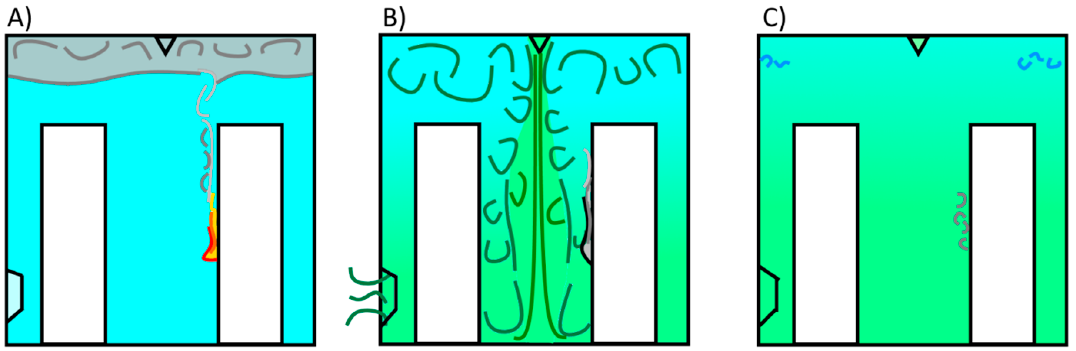
Figure 1. Three stages of the release of extinguishing gas into the compartment. ( A ) Flow field in the compartment dominated by fire growth and smoke buoyancy, prior to release, ( B ) release of the fire extinguishing gas, ( C ) stabilized flow field in the compartment filled with extinguishing gas after the discharge. Stage ( C ) is modelled in this study.